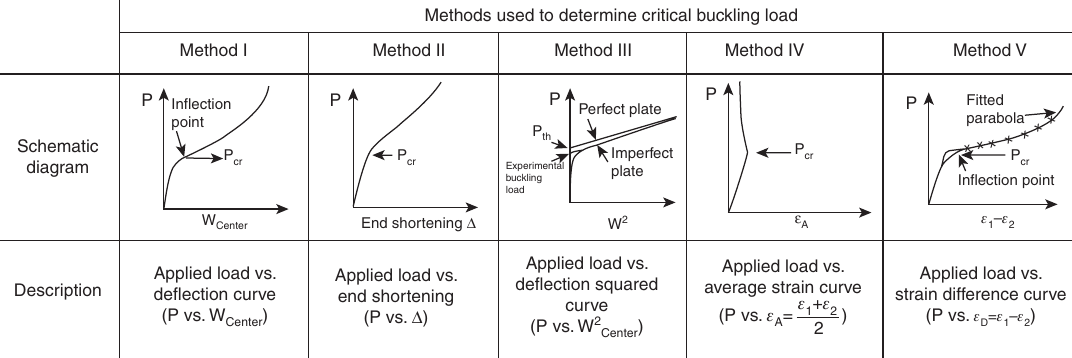
Figure 1 Methods used to determine critical buckling